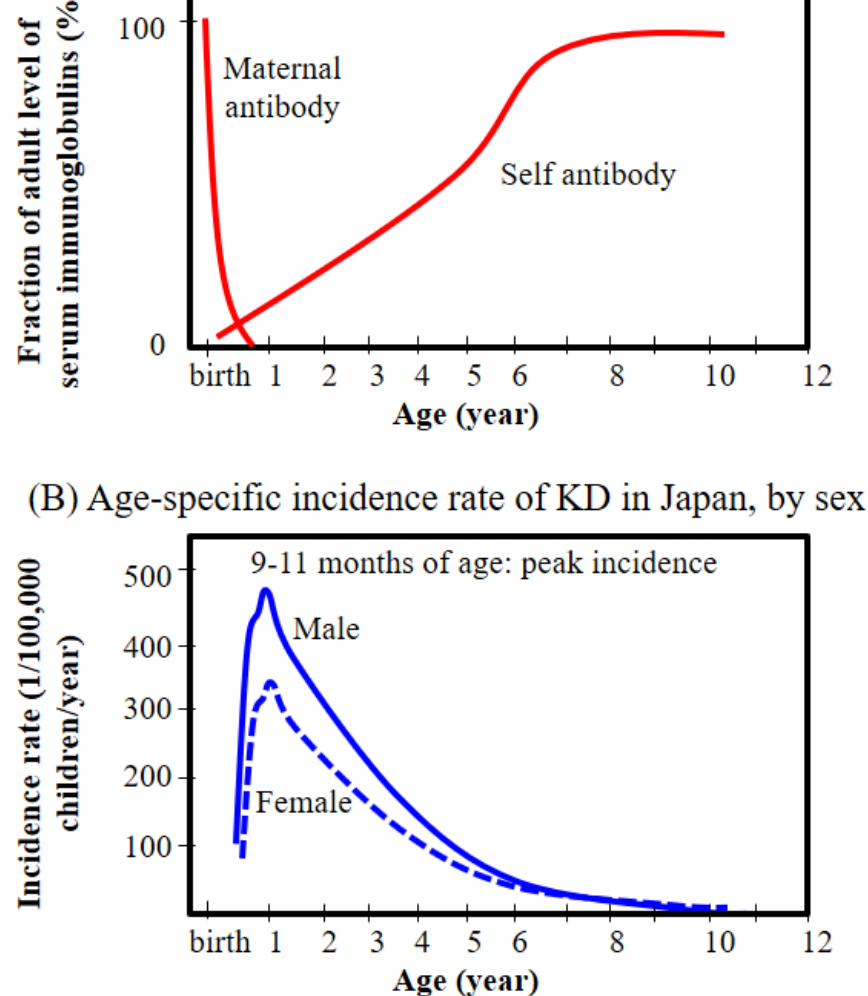
Figure 2. Immunoglobulin levels in children ( A ) and age-specific incidence rates of Kawasaki disease (KD) in Japan ( B ). The immunoglobulin levels in children depicted above were obtained from an immunology textbook [58]. The age-specific incidence rate of Kawasaki disease (KD) by sex was simplified from epidemiological data of Japan [33].